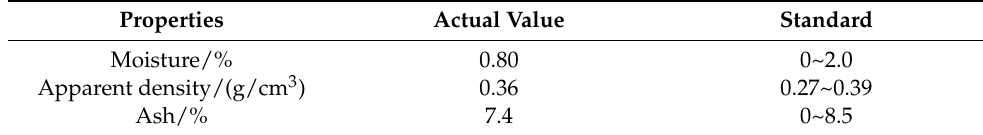
Table 2. Properties of 40 mesh CRM.